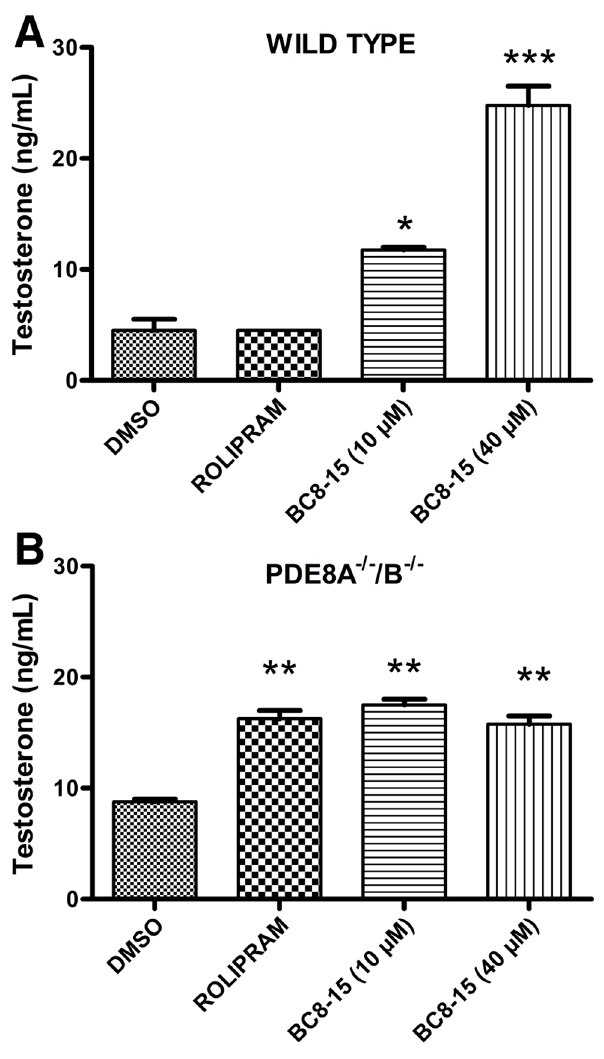
Figure 4. BC8-15 elevates testosterone release by primary Leydig cells. Leydig cells isolated from wild-type (Panel A) and PDE8A 2 / 2 / B 2 / 2 knock-out (Panel B) mice were treated with rolipram (20 m M) or BC8-15 (10 m M and 40 m M) for three hours. Testosterone released into the media was assayed in duplicate for each condition. Values represent the mean 6 SEM. Data from wild type and knock-out samples were separately analyzed with one-way ANOVA followed by Tukey’s multiple comparison test. Significant differences are indicated in comparison to the DMSO control (* p , 0.05, ** p , 0.01, *** p ,